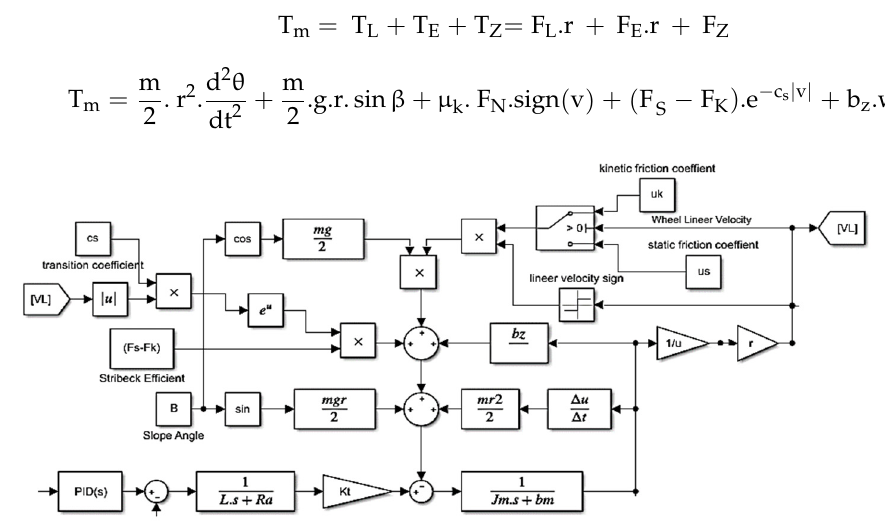
Figure 3. Mobile robot SIMULINK Model with friction, slope, and load parameters.